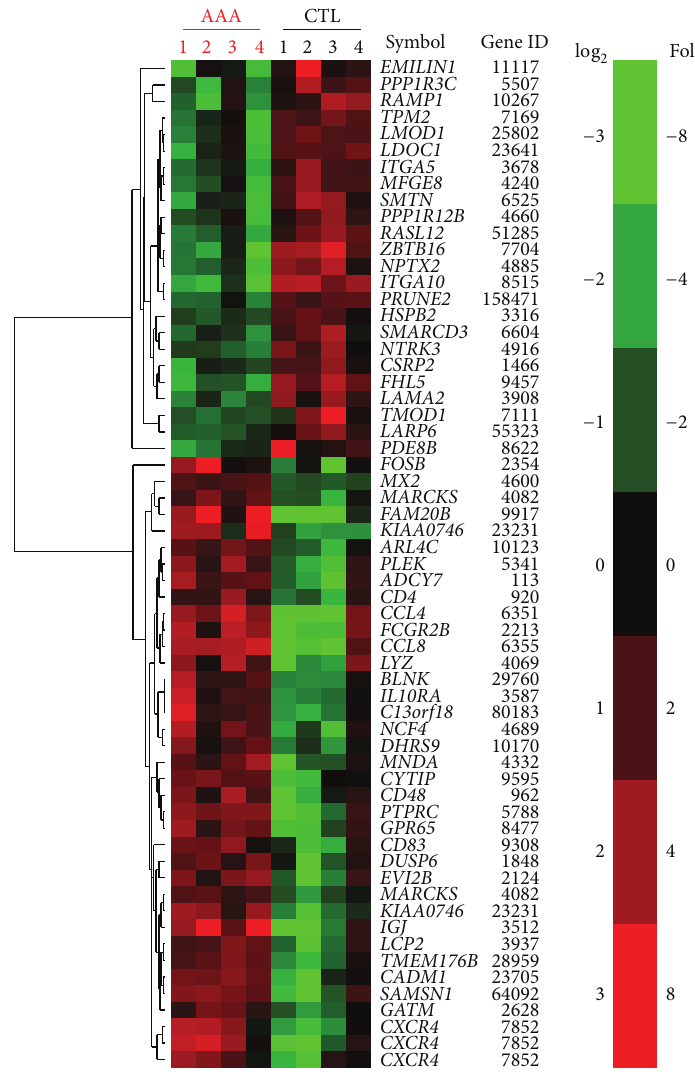
Figure4:Heatmapofthe57differentiallyexpressedgenesfoundintwoindependentmicroarraystudiesforAAA.Theheatmapwasproduced by hierarchical clustering of the probeset data. Probesets for genes are represented by rows with the gene dendrogram at left. There are 61 probesets represented since there are redundant probesets on the Affymetrix microarray for some genes, for example, CXCR4, which is the gene represented by three lines at the bottom. Gene symbols and gene IDs on the right (found at http://www.ncbi.nlm.nih.gov/). Samples (4 AAA samples and 4 controls) are represented by columns. Green color indicates decreased expression in AAA and red color indicates increased expression in